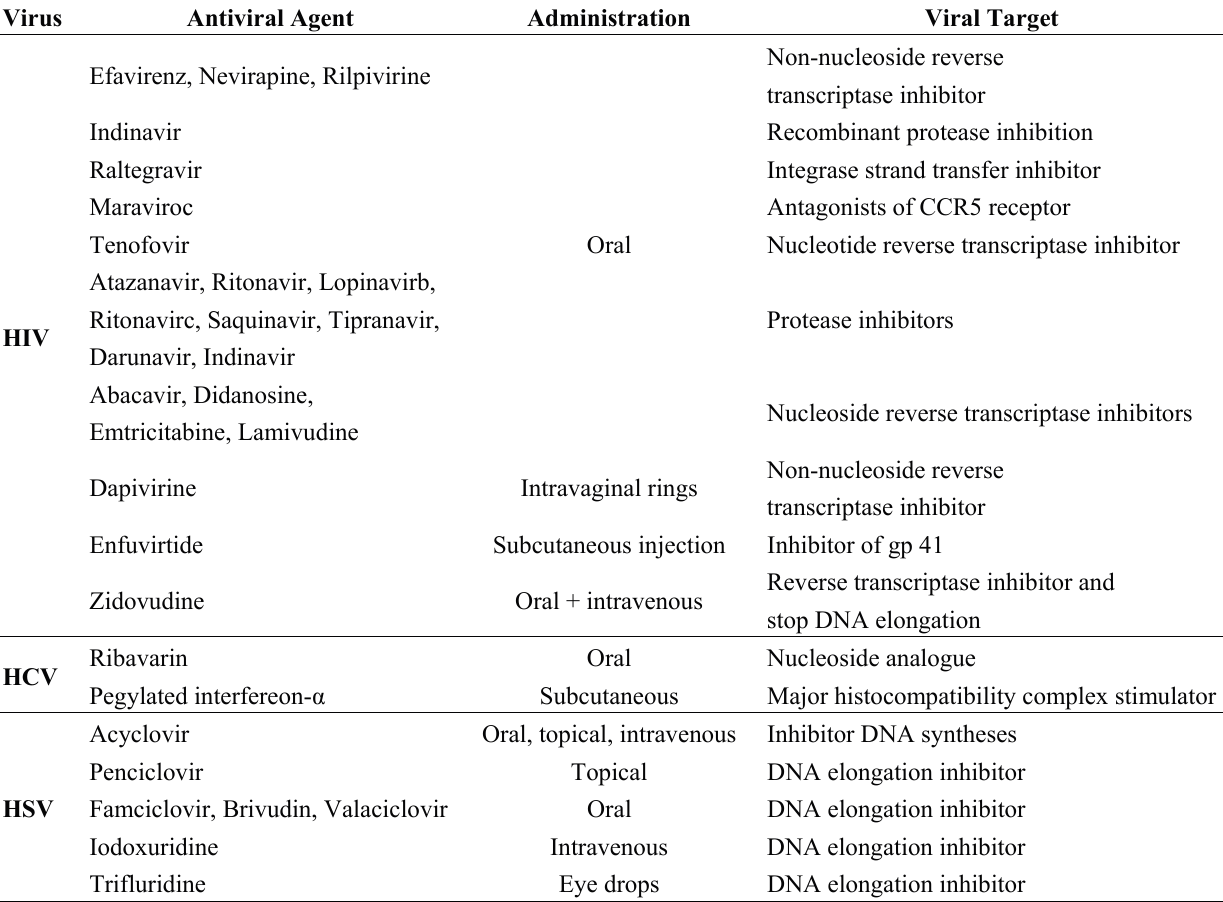
Table 1. List of some approved antiviral drugs for human immunodeficiency virus (HIV), hepatitis C virus (HCV), herpes simplex virus type 1 and type 2 (HSV-1, HSV-2)